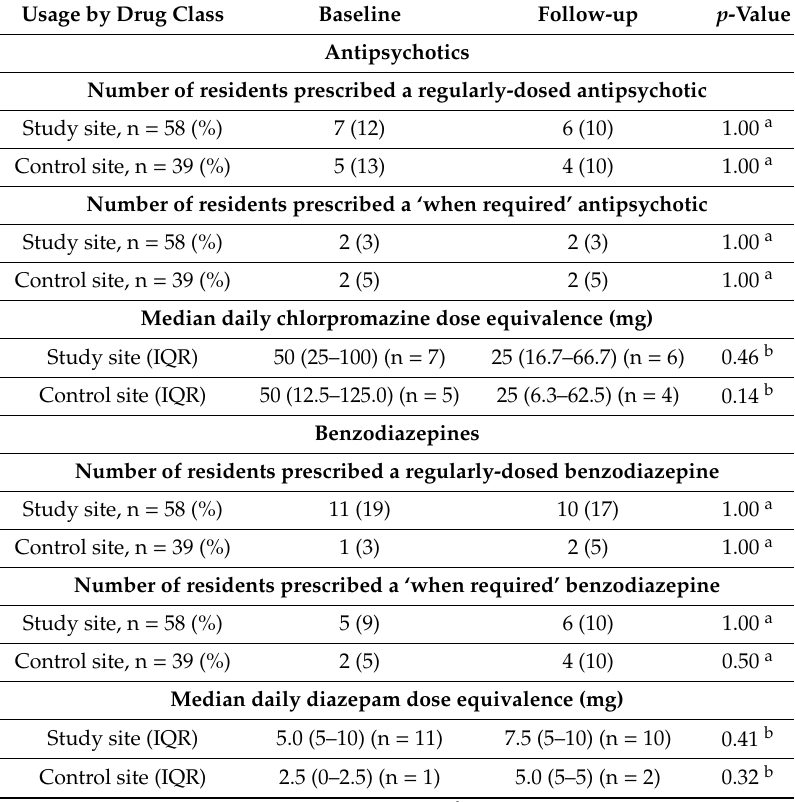
Table 3. Summary of antipsychotic and benzodiazepine